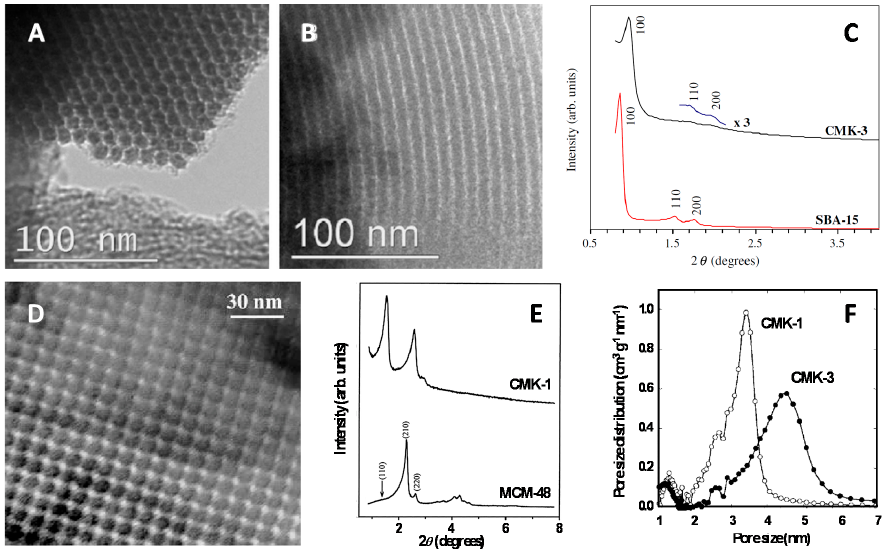
Figure 3. ( A , B , D ) TEM micrographs and ( C , E ) XRD diffractograms of ( A , B , C ) hexagonal CMK-3 and ( D , E ) cubic CMK-1 materials. TEM views of CMK-3 show both the hexagonal packing ( A ) and the long mesopores ( B ), while XRD data include also the diffractograms corresponding to the mother SBA-15 ( C ) and MCM-48 ( E ) mesoporous silica templates. ( F ) Pore size distributions for CMK-3 and CMK-1. Data have been reproduced/adapted from [38] ( A , B ), [40] ( C ), [39] ( D ), [16] ( E ), and [33,41] ( F ).